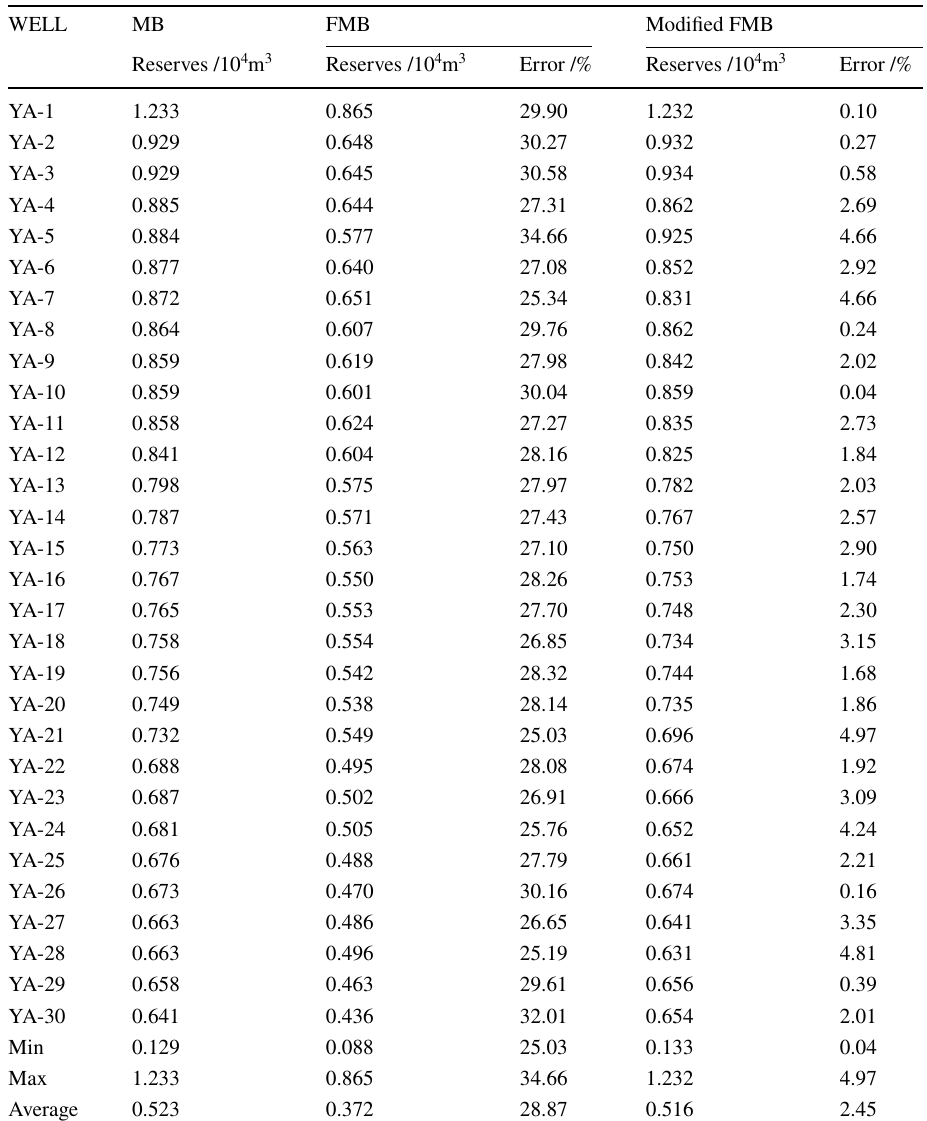
Table 7 Calculation results of three dynamic reserve